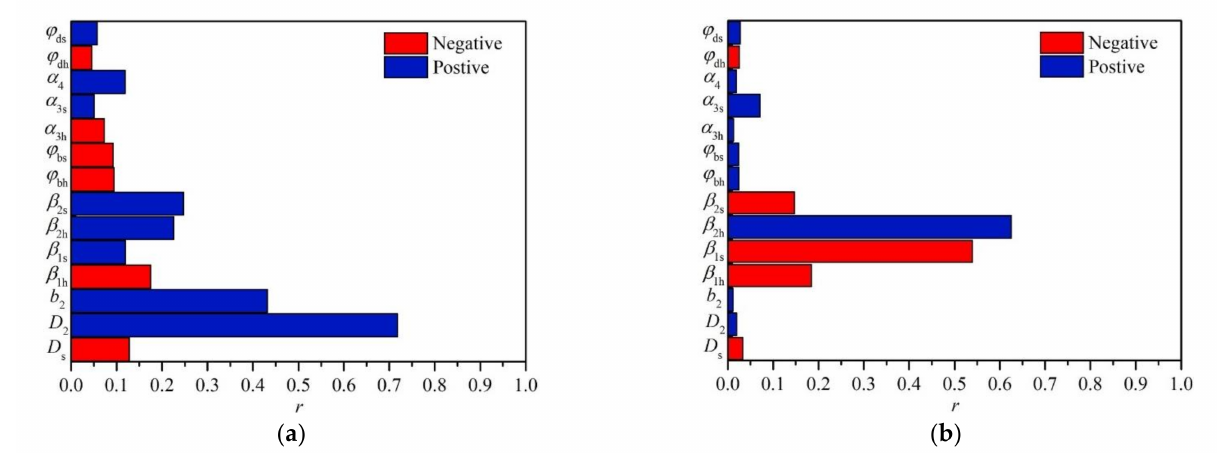
Figure 10. Correlation analysis for objectives. ( a ) Effect on head. ( b ) Effect on efficiency.